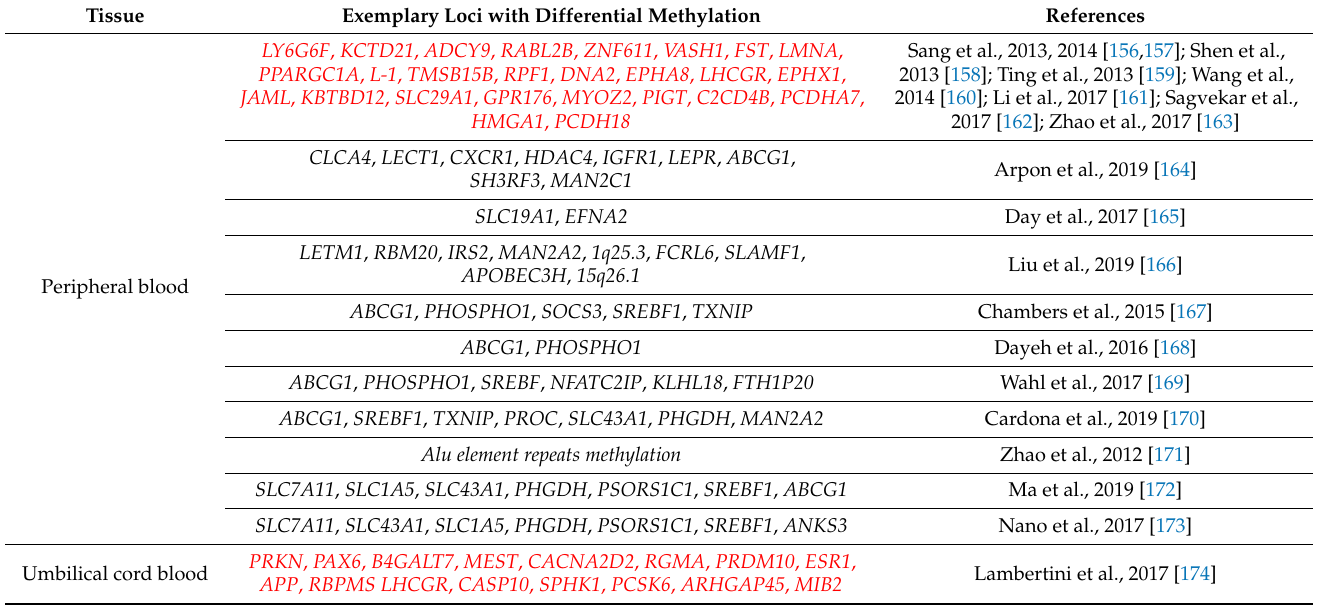
Table 1. Hypermethylated or hypomethylated genes affecting IR including those found in tissue from patients with PCOS (marked in red). Modified from the respective review papers [44,155].